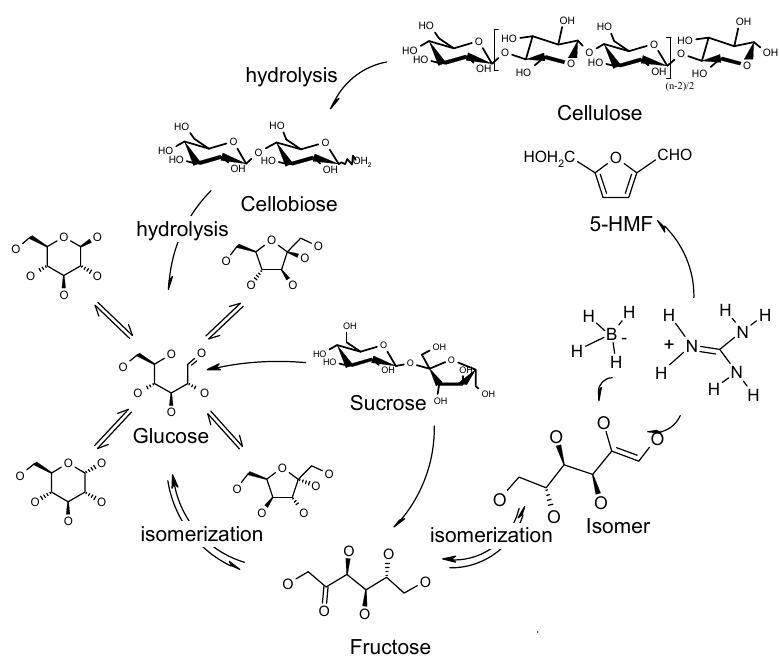
Figure 4. Possible pathway of the conversion of carbohydrates to 5-HMF with [TMG]BF 4 as a catalyst.